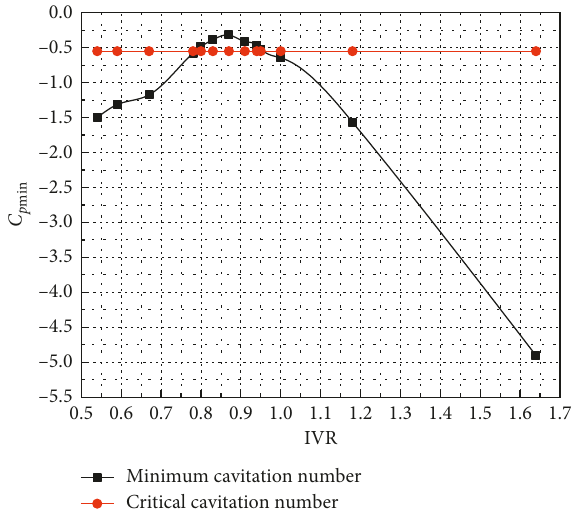
Figure 15: Minimum cavitation number C